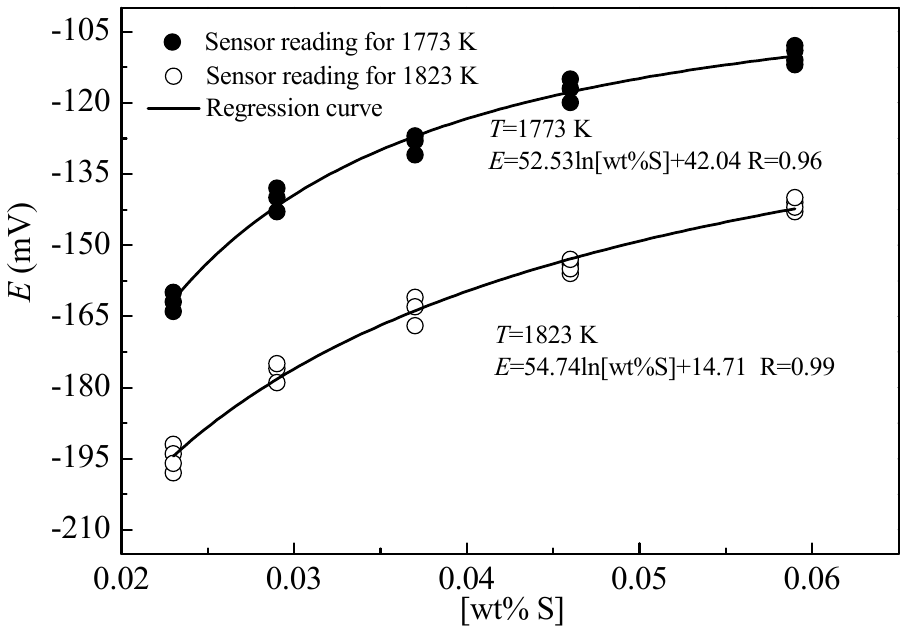
Figure 5. Relationship between sensor electromotive force (EMF) and sulfur content.